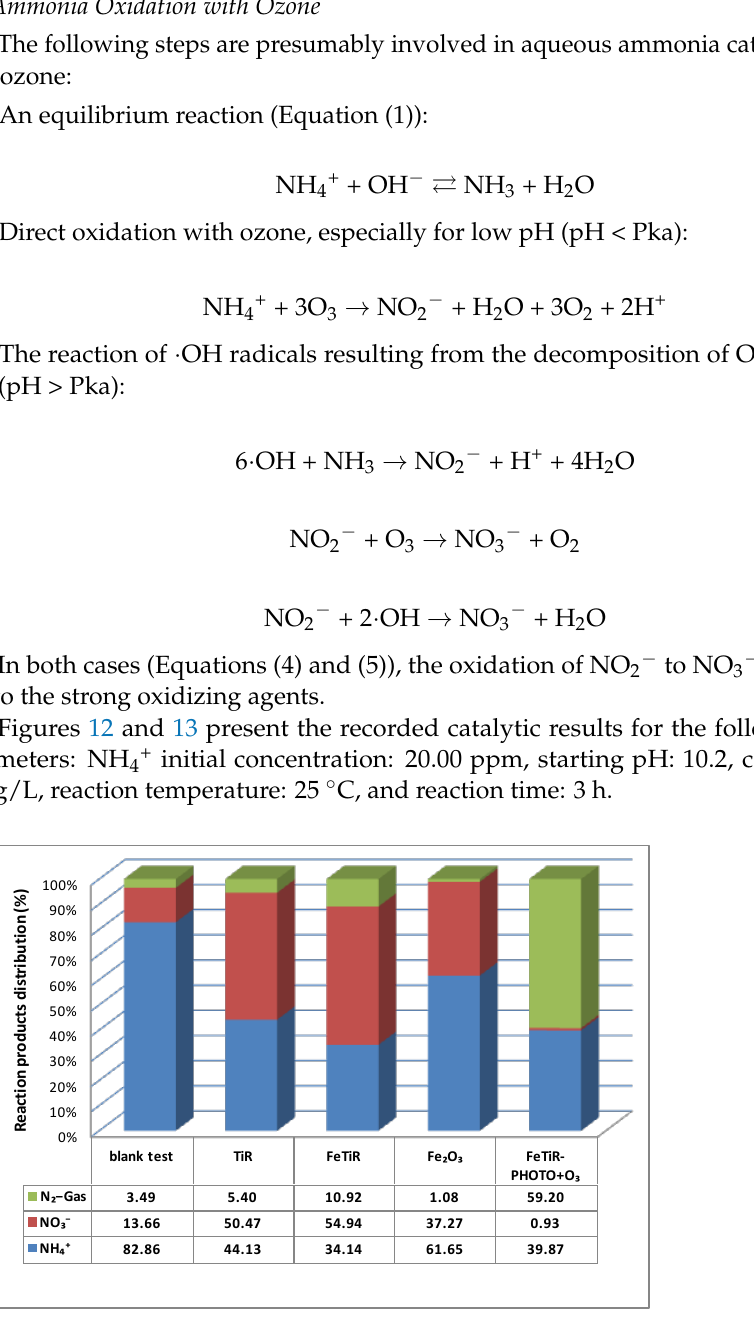
Figure 12. Reaction products distribution for aqueous ammonia oxidation with ozone and a photo- assisted process (carried out for FeTiR catalysts).